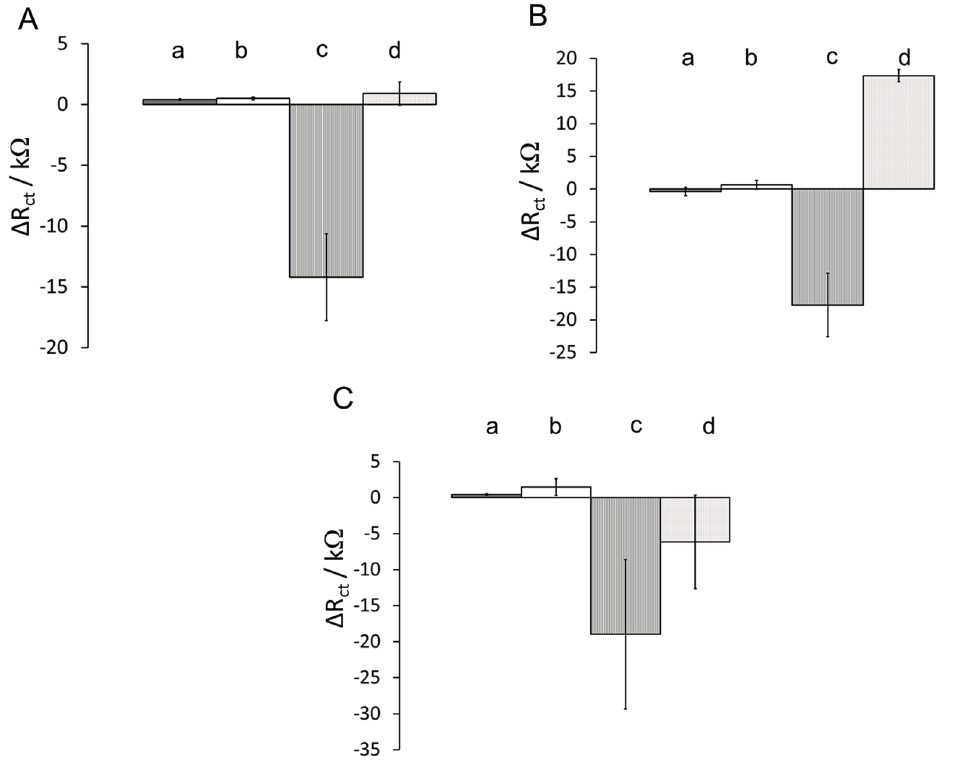
Figure 6. Plot of change in R ct as a function of protein solution during ( A ) CD13; ( B ) BSA; and ( C ) mucin protein adsorption on YNGRT-Au with various surfaces: (a) ethanolamine/2-mercaptoethanol, (b) ethanolamine/hexanethiol, (c) n -butylamine/hexanethiol, (d) n -butylamine/2-mercaptoethanol (protein concentration was 10 µg·mL − 1